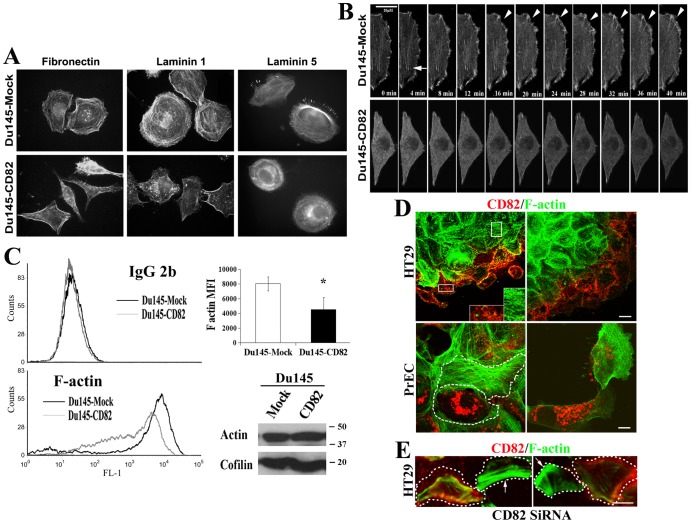
The actin cortical meshwork and stress fiber were disrupted upon KAI1/CD82 expression.(A
) F-actin distribution. After being spread on FN (50 µg/ml)-, LN1 (50 µg/ml)-, or LN5 (2 µg/ml)-coated coverslips at 37°C, 5% CO2 for 6 h, Du145 transfectant cells were fixed, permeabilized, and then stained with TRITC-conjugated α-phalloidin. The fluorescent images were captured under an Axiophot fluorescent microscope equipped with an Optronics digital camera at magnification 63X. (B
) Live imaging of actin polymerization in Du145-Mock and -KAI1/CD82 cells. The cells that were transiently transfected with pEGFP-actin construct were spread on FN-coated coverslips in complete DMEM and photographed using time-lapse confocal videomicroscopy. Arrowheads and arrows indicate actin polymerization during the development of peripheral meshwork and stress fiber, respectively. (
C
) Less F-actin in Du145-KAI1/CD82 cells. Left panel, Du145-Mock and -KAI1/CD82 cells spread in serum-free DMEM were detached, fixed, permeabilized, incubated with Alexa 488-conjugated phalloidin or mouse IgG2b, and then analyzed with flow cytometry. Right top panel, quantitation of the mean fluorescence intensity (MFI) of F-actin. Data are expressed as the mean MFI of three independent experiments (P<0.05 between Mock and KAI1/CD82 cells). Right bottom panel, the cell lysates from the experiment were analyzed by Western blot for total cellular actin proteins. Cofilin blot was used as the protein loading control. (
D
) The presence of KAI1/CD82 proteins is inversely correlated with actin cytoskeletal assembly. HT29 colon cancer cells and prostate epithelial cells were fixed, permeabilized, and incubated with Alexa 488-conjugated phalloidin and Alexa 594-conjugated KAI1/CD82 mAb. The images were acquired with confocal microscopy. For HT29 cells, the photographs were taken from the basal sections of the cells. Shown in insets is the magnified staining from the frame-selected areas. White dashed lines outline the cell boundary. Scale bars: 10 µM. (
E
) KAI1/CD82 silencing leads to stress fiber formation. HT29 cells were transiently transfected with KAI1/CD82-specific siRNA duplexes, seeded sparsely, and stained with Alexa 488-conjugated phalloidin and Alexa 594-conjugated KAI1/CD82 mAb as described above. Scale bar: 10 µM. White dotted lines outline the cell periphery. Arrows indicate the cells exhibit robust stress fiber formation but no KAI1/CD82 staining.